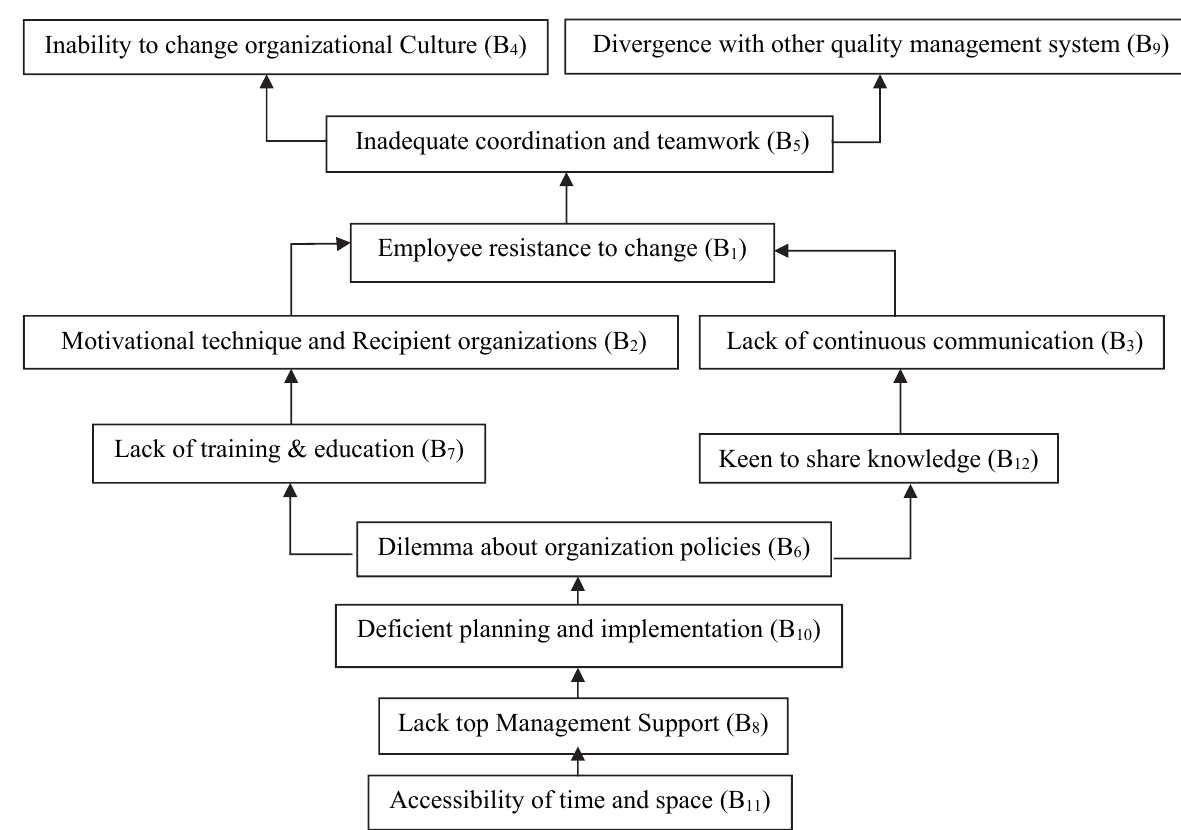
Fig. 3. Interpretive structural model showing levels of barriers affecting